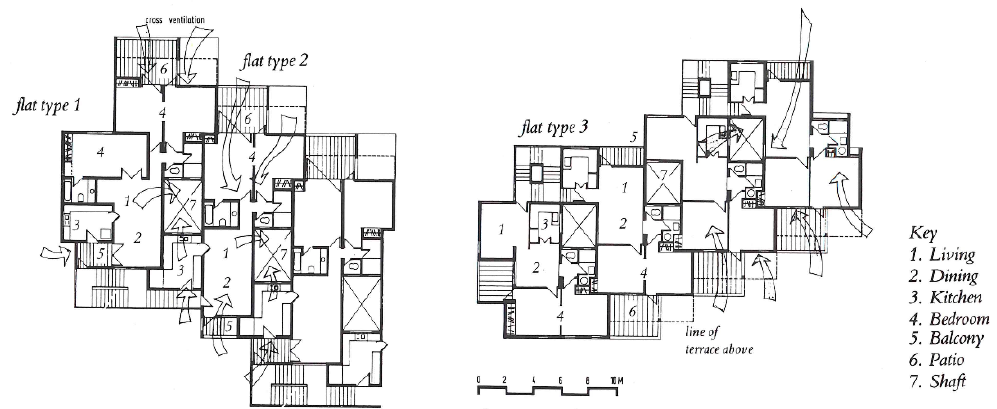
Figure 4. Floor plans of the three unit types with arrows depicting cross-ventilation [19].